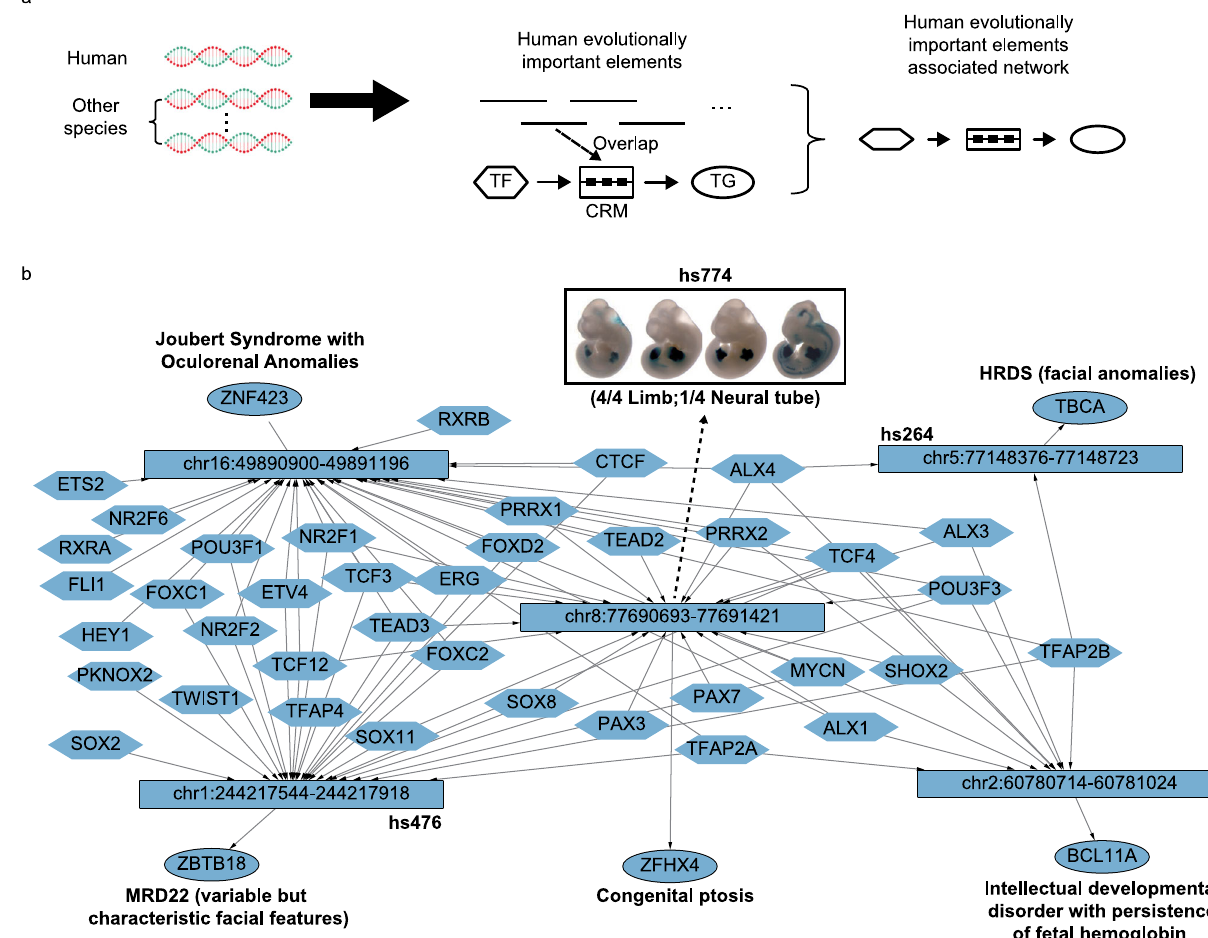
Fig. 6 hReg-CNCC interprets the DNA difference in evolution and uncovers important regulatory elements and genes. a The scheme to extract the subnetwork in hReg-CNCC associated with human evolutionarily important elements from comparative genomics. If one human evolutionarily important element is overlapped with CRM, this TF-CRM-TG triplet is extracted and pooled into a subnetwork. b The evolutionarily UCEs associated network. Instead of the whole CRM, only the REs associated with evolutionary elements are shown. Vista enhancer and literature evidence are annotated and support their importance in face